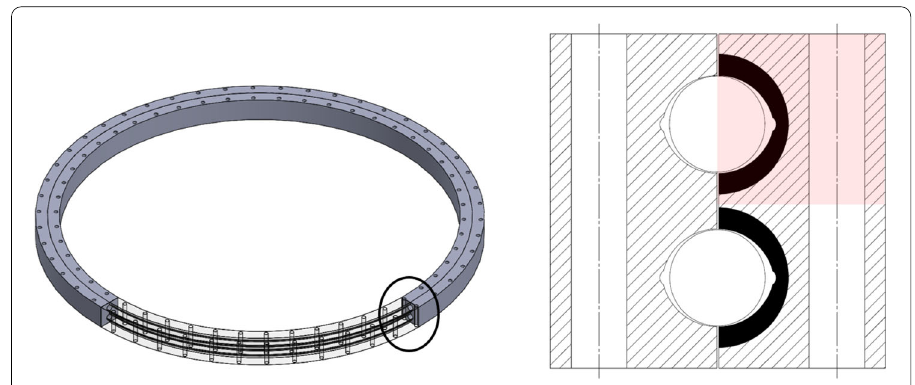
Fig. 11 Typical pitch bearing geometry (left) and its cross section with the area of study shaded in red (right). The black thick lines indicate the hardened